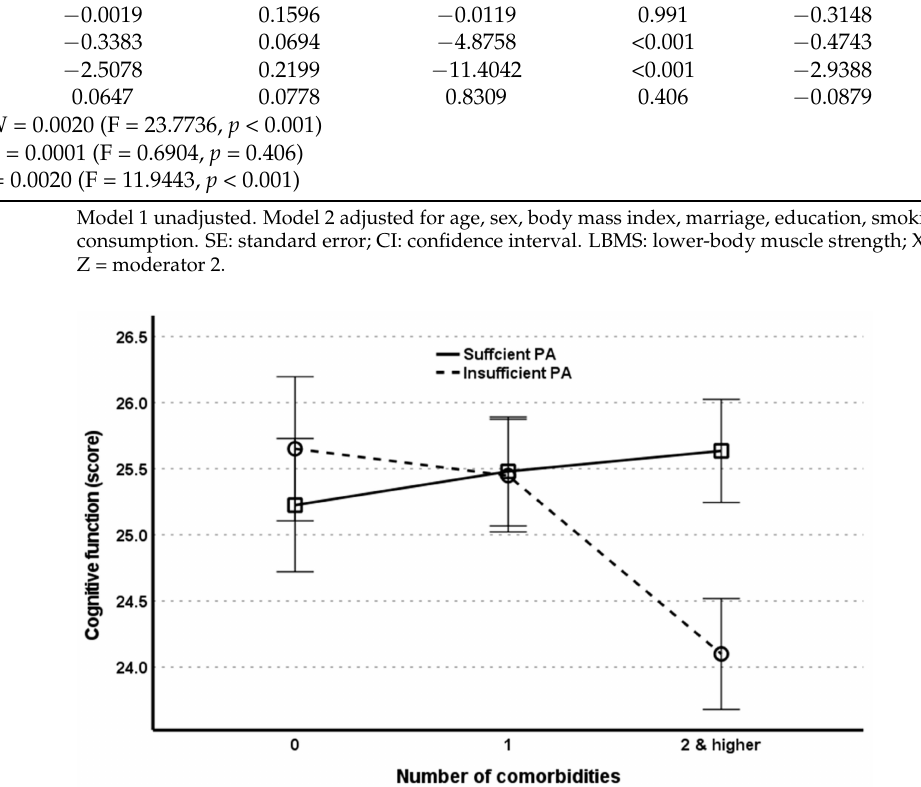
Figure 2. Effect of physical activity (PA) on the relationship between comorbidities and cognitive